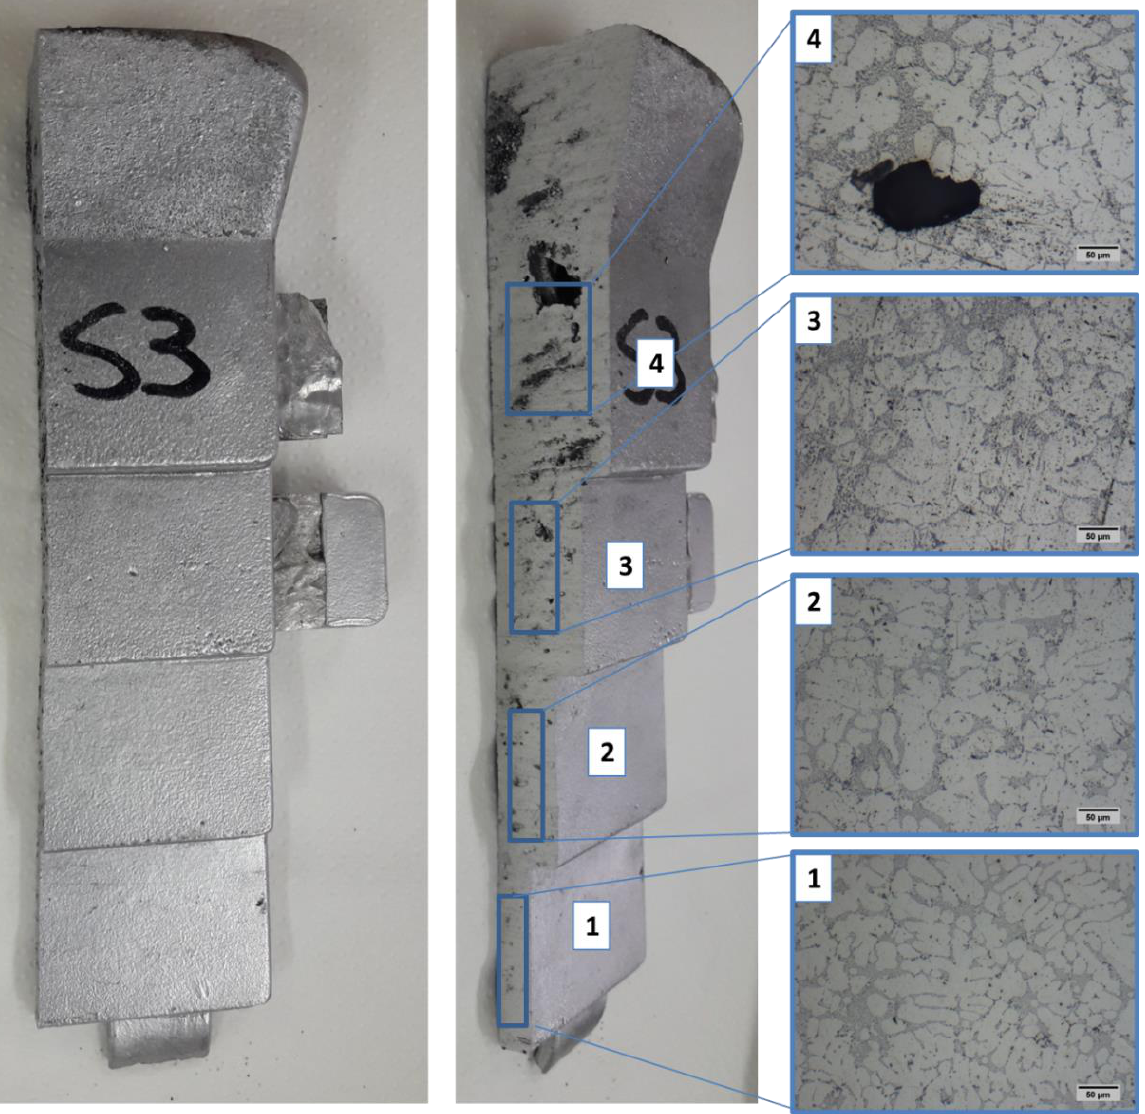
Figure 7. Foam 1 inserted in cast object, visual appearance of the cast object (top surface and cross section), and optical microscopy on the cross section. 1 – 4 optical images of the different steps of the cast object